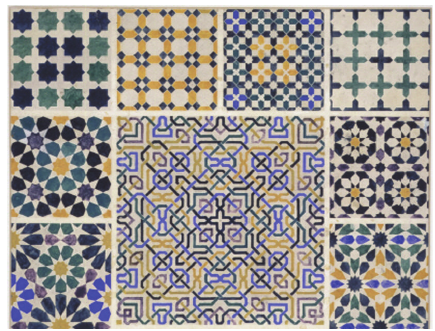
Figure 4: Owen Jones, 1856.